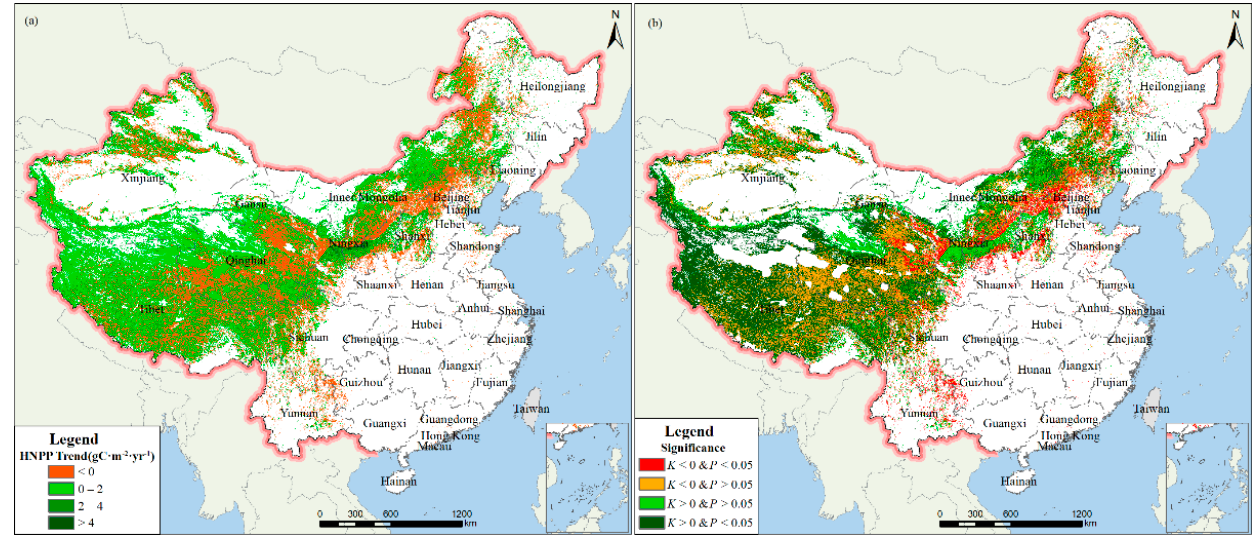
Figure 9. ( a ) Trend in HNPP (2001–2020) and ( b ) the significance levels. (Note: K is the change trend of ANPP, and P is the significance levels). Using the calculation results for the ANPP, PNPP, and HNPP change trends, the contribution of CC and HA to ANPP changes were assessed, and the areas that were largely influenced by CC were compared to those primarily affected by HA. Of the 38.4% of the ANPP area affected by CC and HA, climate-dominated areas accounted for 47.8%, whereas human-dominated areas accounted for 13.8% (Figure 10a).